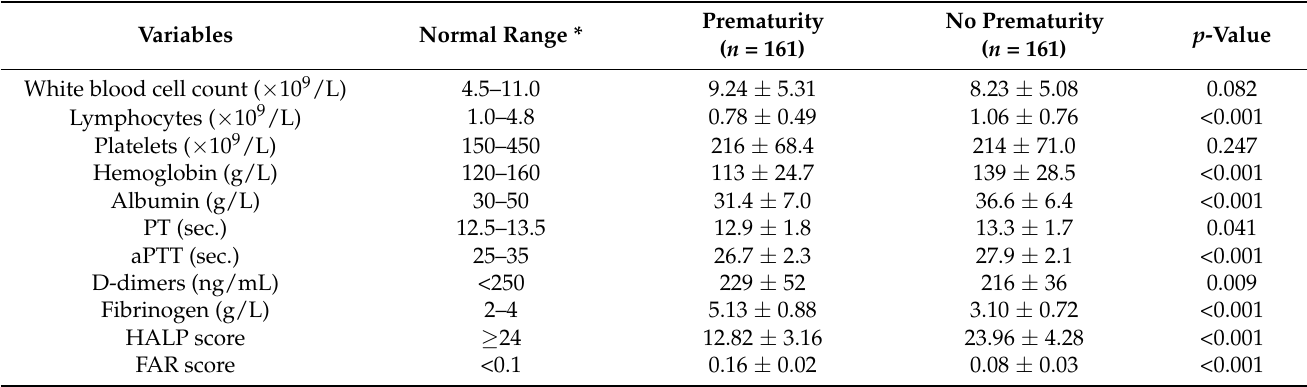
Table 2. The analysis of serum parameters is used to assess the risk of premature